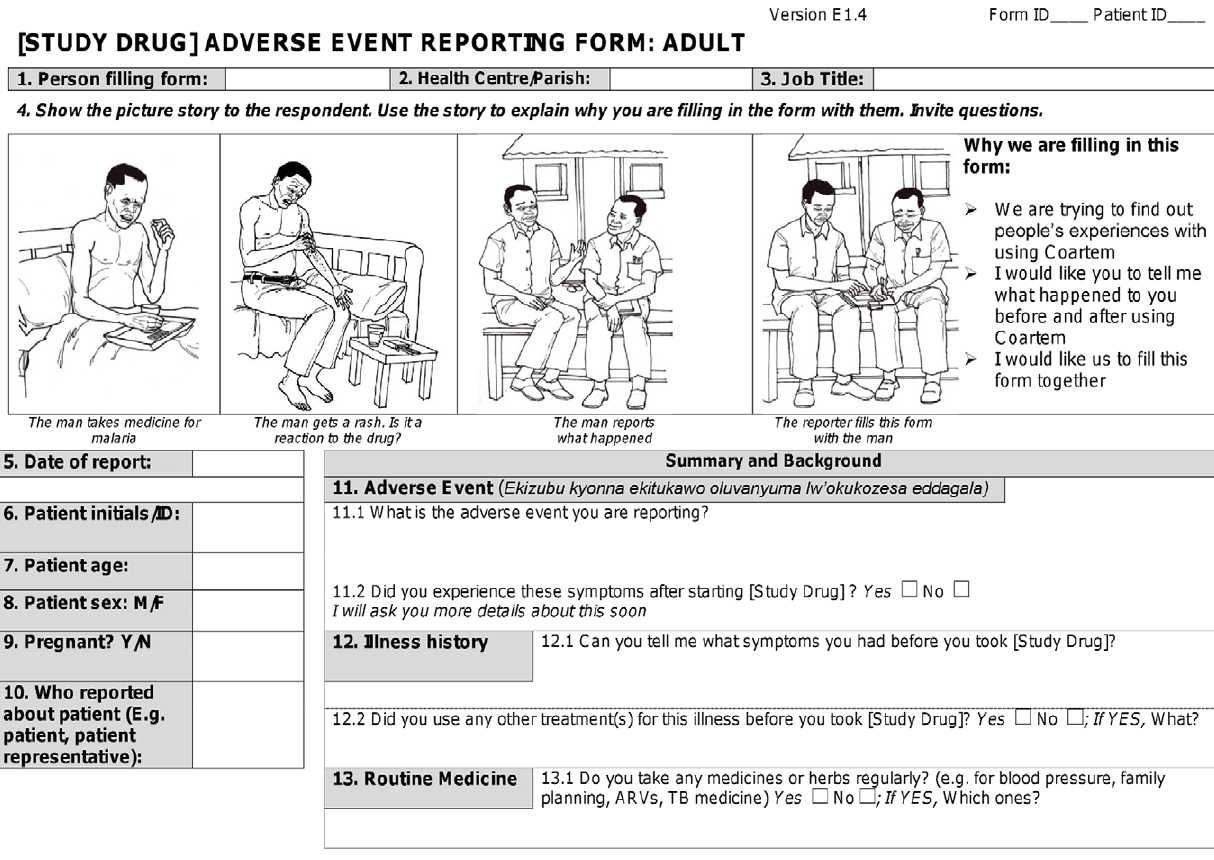
Figure 4. Final draft of passive reporting form for adult patient (Page 1).